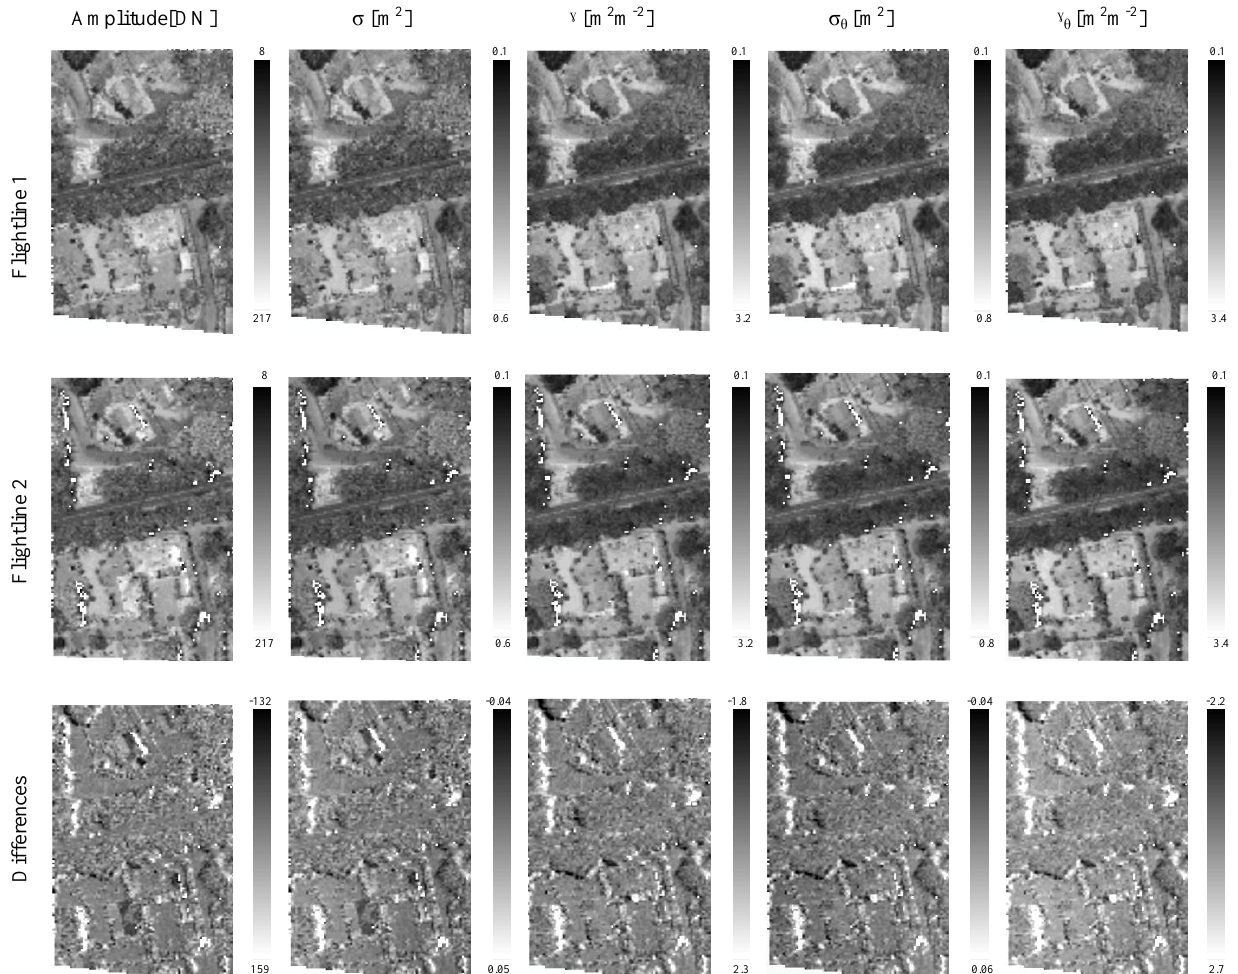
Figure 4. Difference maps for two overlapping flightlines, showing the original echo amplitude signals and the backscatter cross-section parameters for an interest area in the Bournemouth study